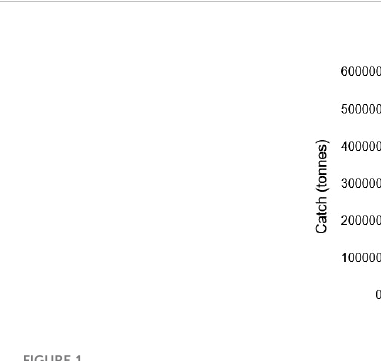
FIGURE 1 Antarctic krill catch 1970-2020 (CCAMLR,